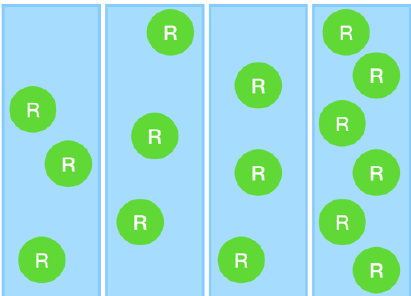
Figure 1: Regional elements in the Berlin Curriculum (blue: thematic elements, green: Regional Geography) Source: the